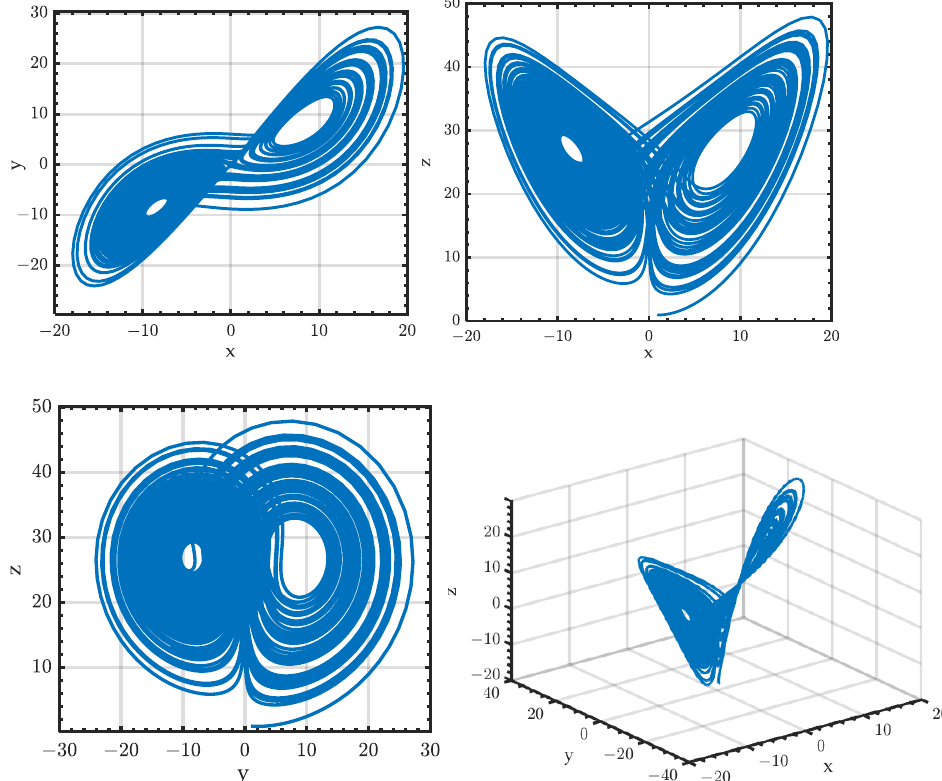
Figure 3. Lorenz attractor trajectories.